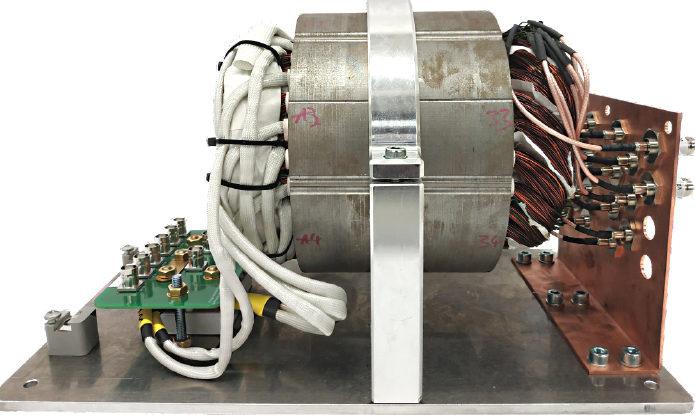
Figure 9. Electrical steel stator specimen S3 with three-phase winding and terminal board on the Figure 9. Stator specimen S3 made of electrical steel with three-phase winding and terminal left side and inter-winding terminals on the right. This fixture’s base measurements are 300mm by board on the left and inter-winding voltage measurement terminals on the right side. The base dimension of this fixture is 300 mm by 230 mm.